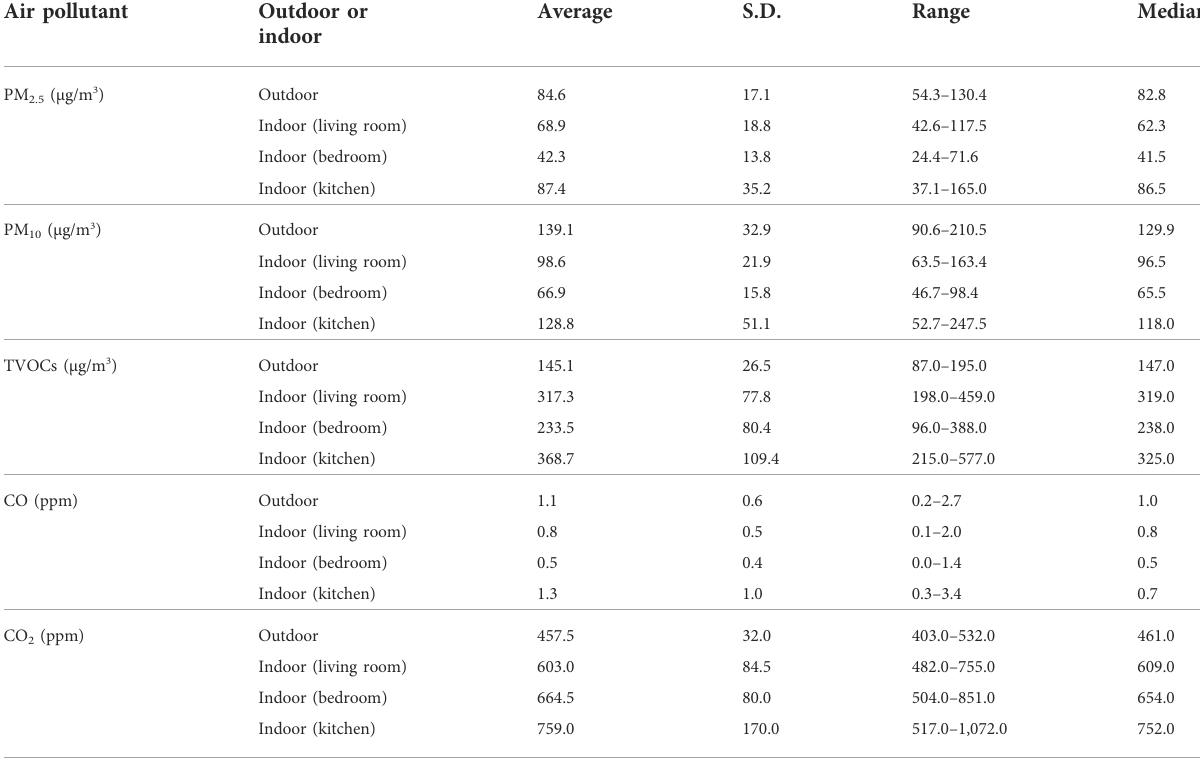
TABLE 2 Outdoor and indoor concentrations of measured pollutants in the studied